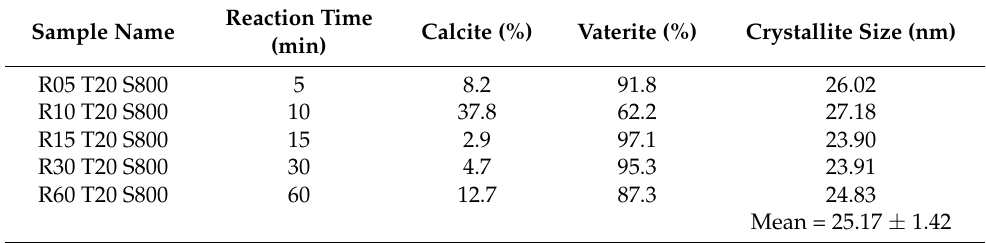
Table 2. Effect of reaction time on the as-prepared CaCO 3 polymorph ratio and size of crystallite (at a temperature of 20 ◦ C and stirring speed of 800 rpm).